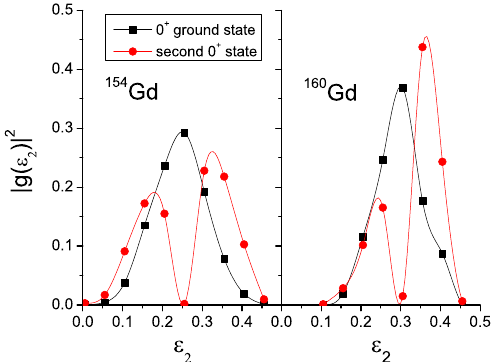
Figure 8. (Color online) Calculated probability function of de- formation for the ground state 0 + and 160 Gd. Symbols correspond to the discrete deformations used for the integration in Eq. (8). This figure is taken from Fig. 4 of Ref.